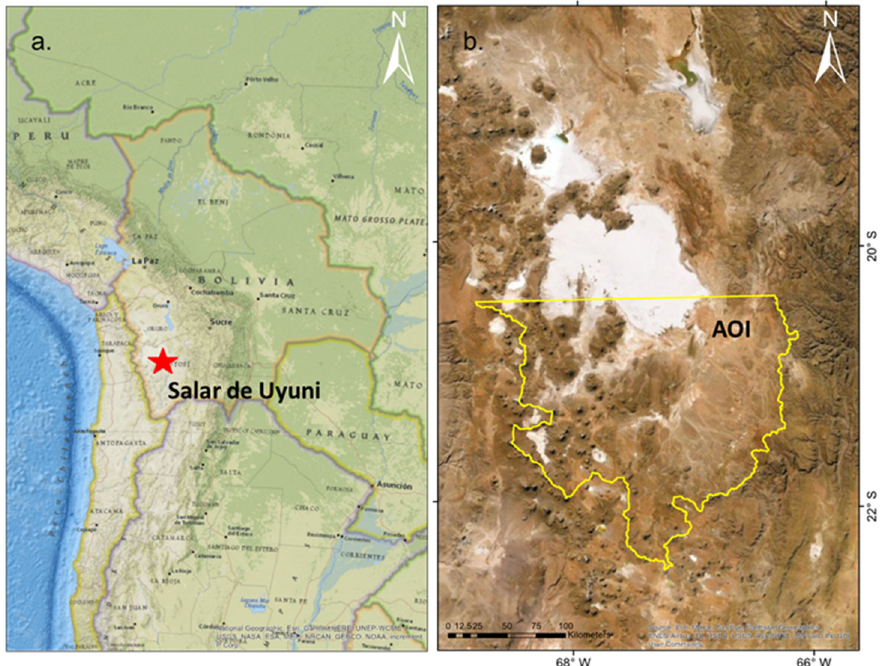
Figure 2. Location ( a ) and extension of the area of interest (AoI) over the Salar de Uyuni in Bolivia ( b ). Basemap images copyright © 1995–2020 Esri.